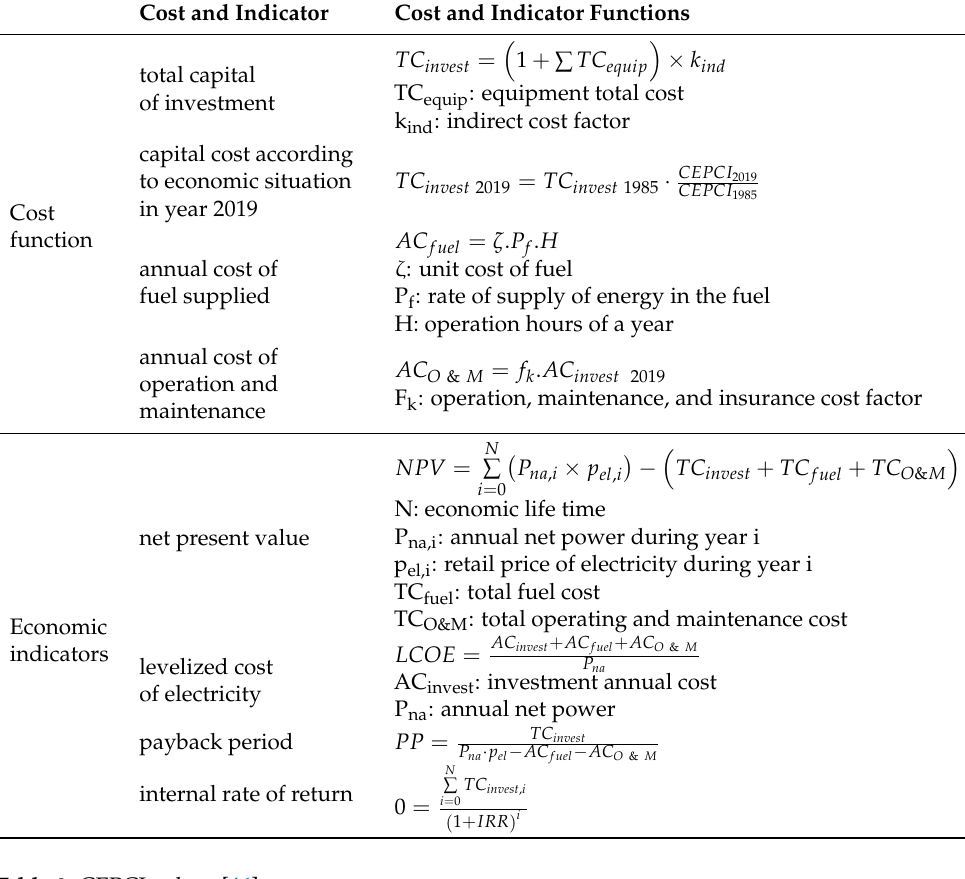
Table 8. Model of economic analysis. Cost and Indicator Cost and Indicator Functions